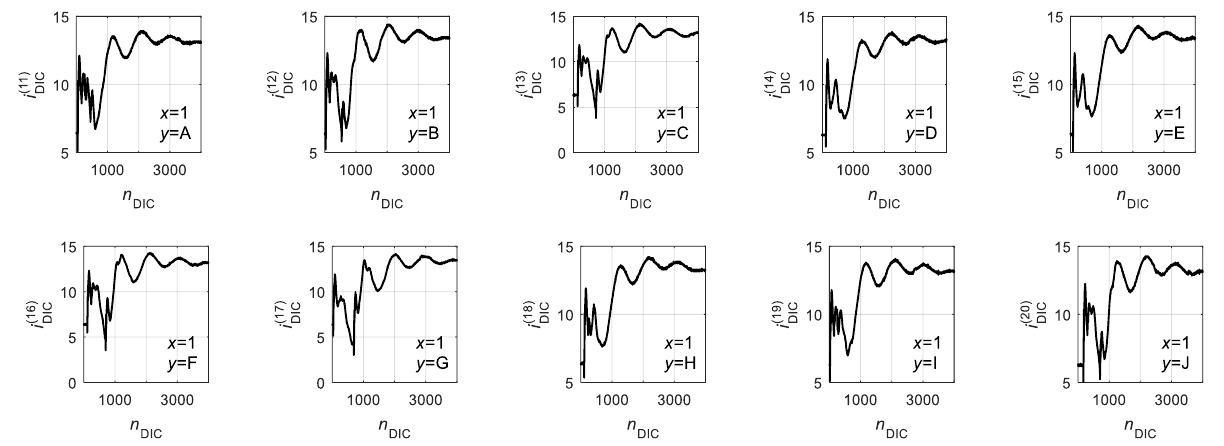
i for the vacuum cleaner = ( 1 ) x . Figure 21. Current vectors i DIC for the vacuum cleaner ( x = 1 ) D I C